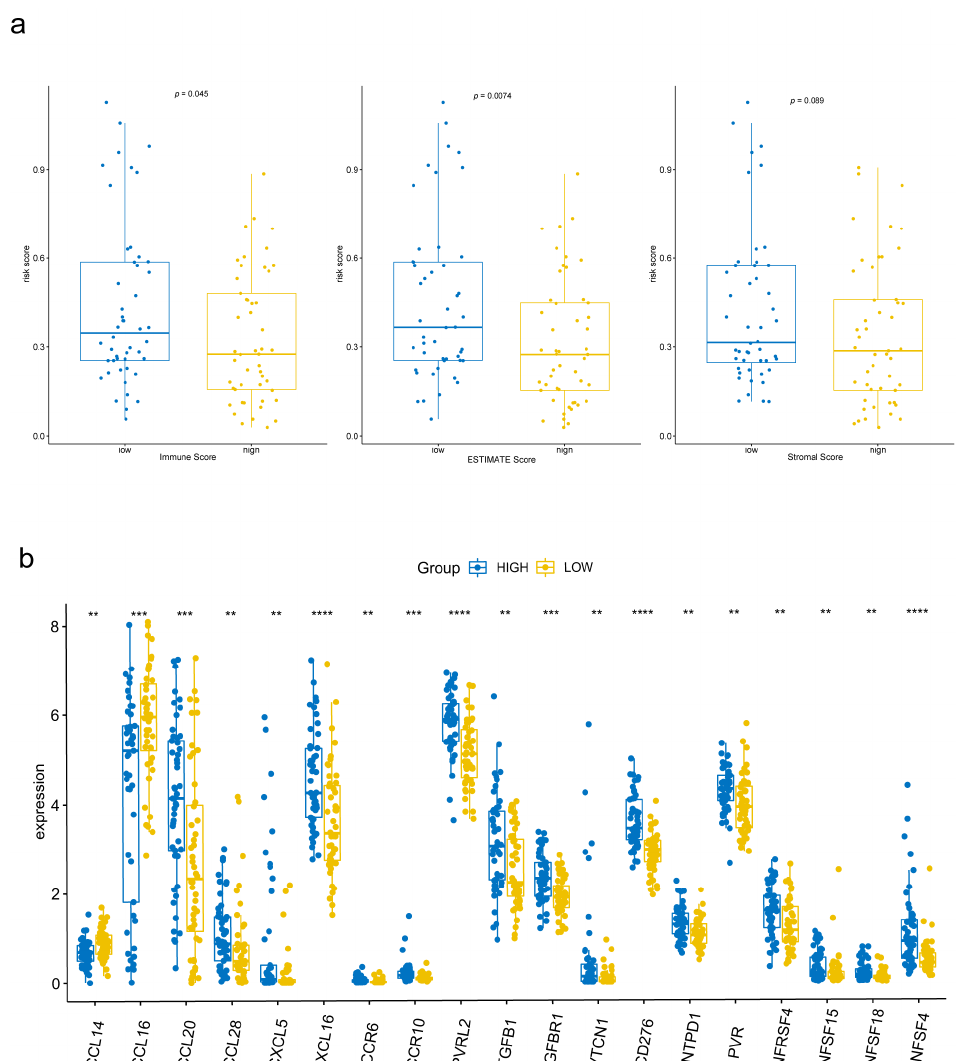
Figure 7. Tumor immunity relevance of the FAM-related signature. ( a ) Relationship among immune scores, ESTIMATE scores, stromal scores and risk scores. ( b ) Differently expressed immune-related genes between the high-risk group and low-risk group. ** p < 0.01, *** p < 0.001, **** p < 0.0001.